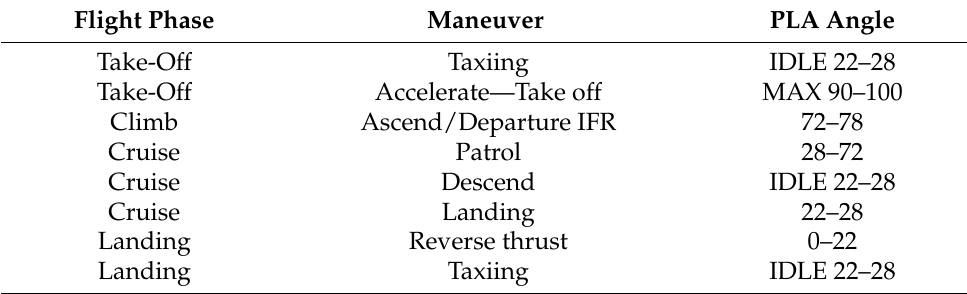
Table 5. EMB-145 Typical PLA